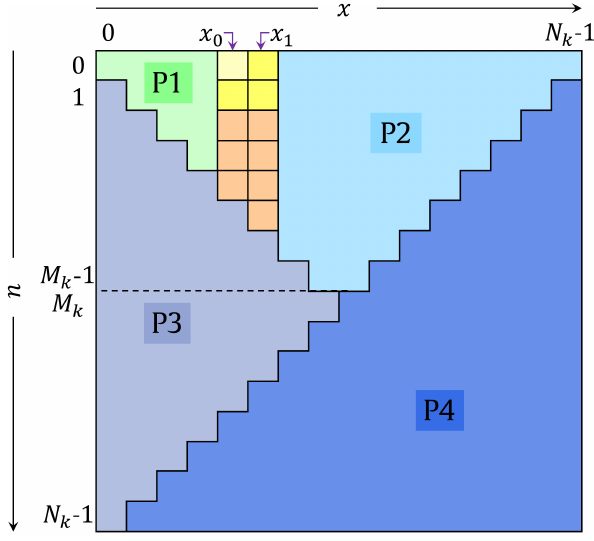
Figure A1. Parts of the